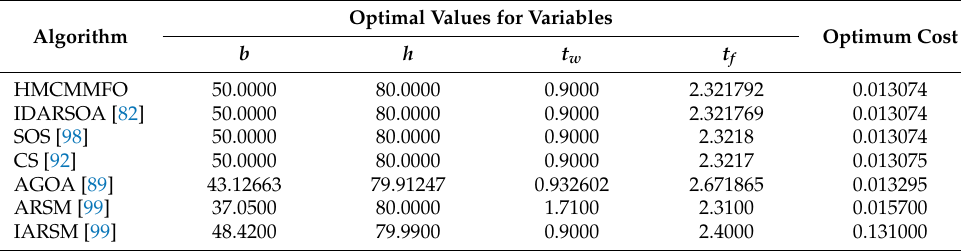
Table 12. Comparison results of the I-beam